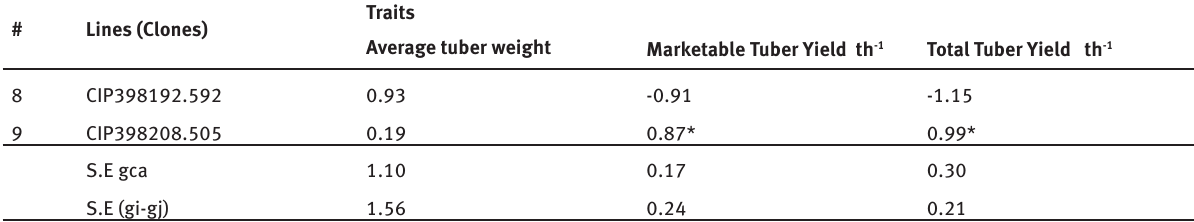
Table 6 continued: Estimates of General Combining Ability (GCA) effects for lines (clones), pooled over locations for average tuber weight, marketable and total tuber yiel in three sets of clones from LBHT population